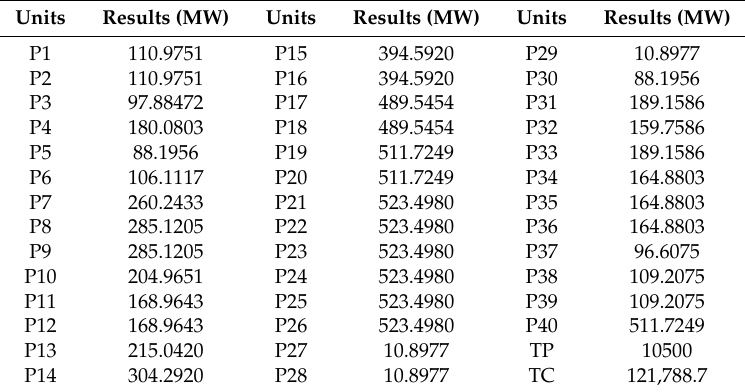
Table 3. Optimization results of 40 units test